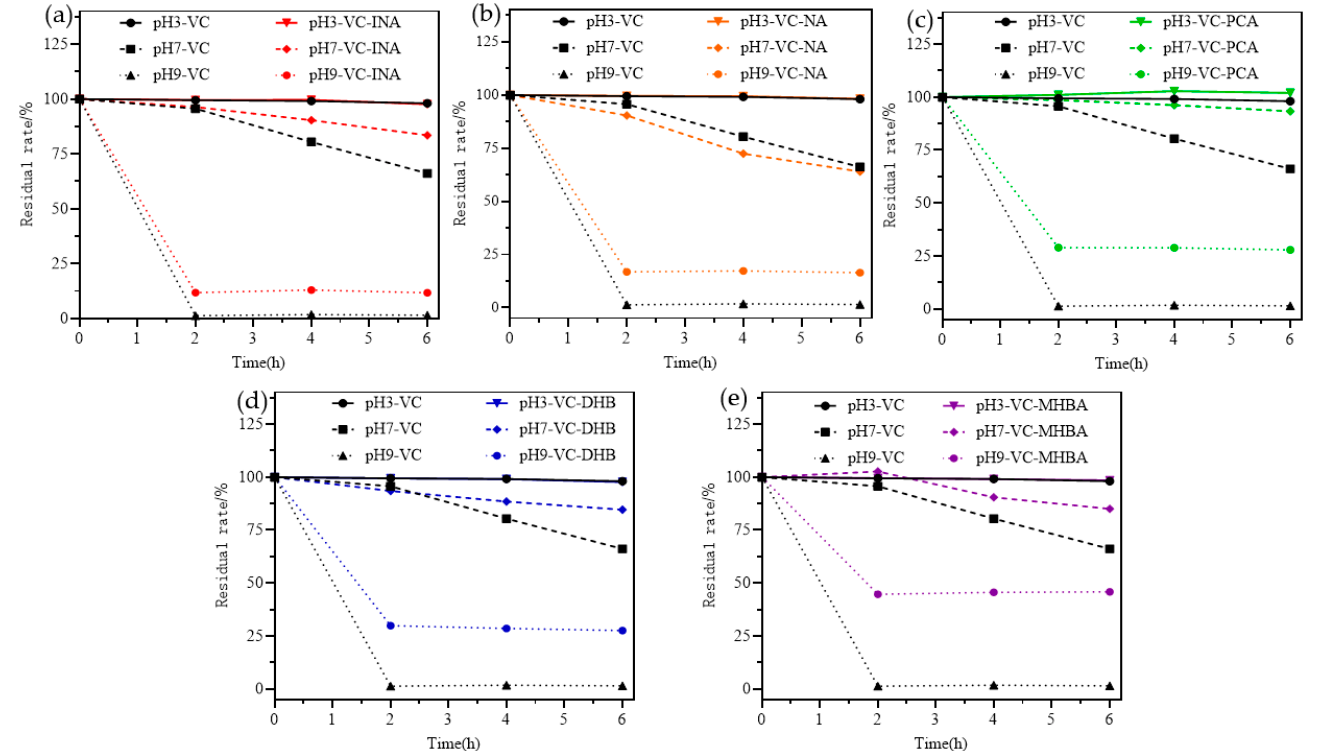
Figure 7. pH stability experiment of VC co-crystals (( a ): VC-INA; ( b ): VC-PCA; ( c ): VC-NA; ( d ): VC-DHB; ( e ): VC-MHBA).